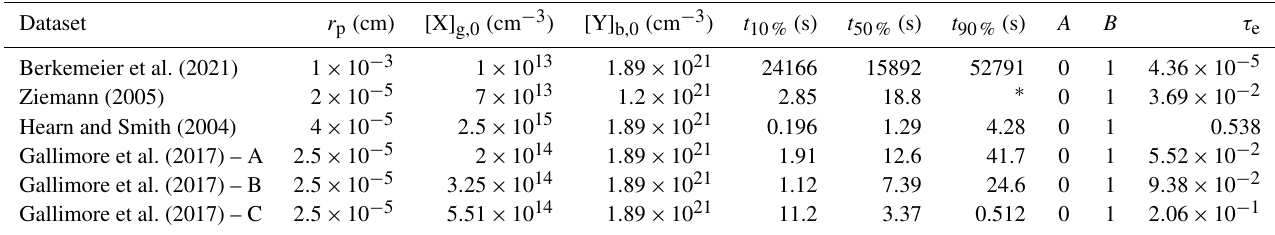
Table B1. Model parameters for the global optimization of six oleic acid ozonolysis datasets. Dataset